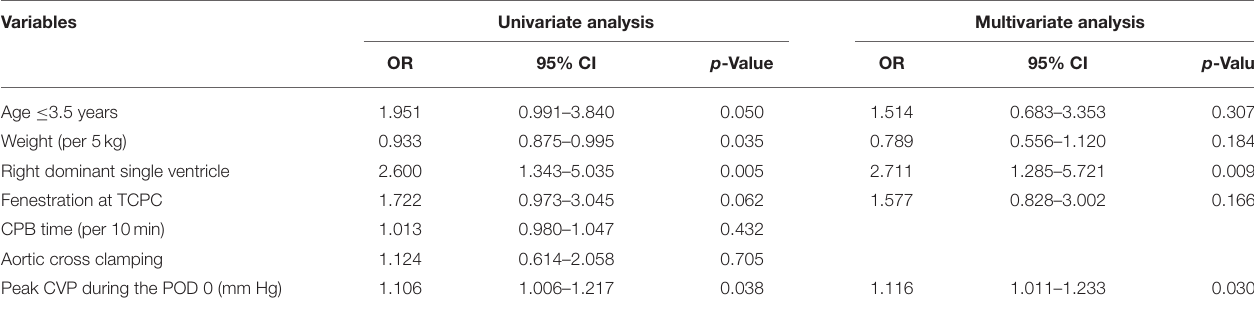
TABLE 2 | Univariable and multivariable analyses of risk factors for chylothorax. Variables